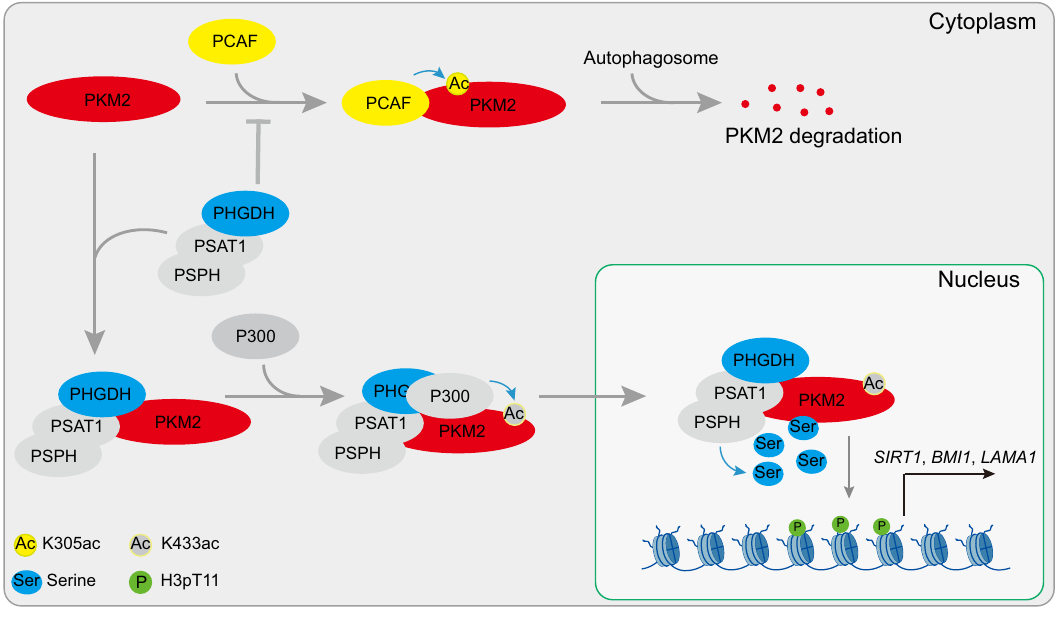
Fig. 8 | Proposed model for regulation of senescence by the PHGDH-PKM2- H3pT11 axis. PHGDH interacts with PKM2, which prevents PCAF-catalyzed PKM2 K305 and subsequent degradation by autophagy. PHGDH also enhances p300- catalyzed PKM2 K433 acetylation and promotes PKM2 nuclear